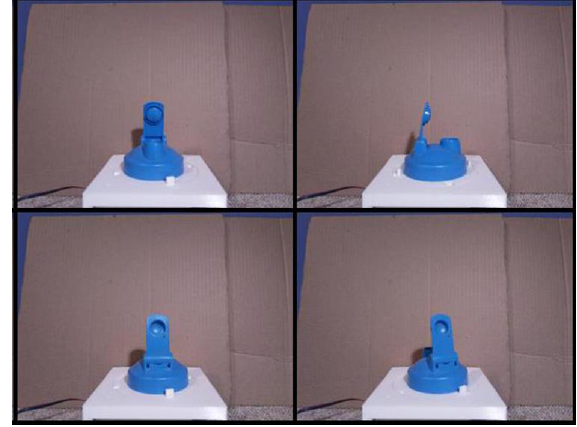
Figure 5. Example images from the first experiment